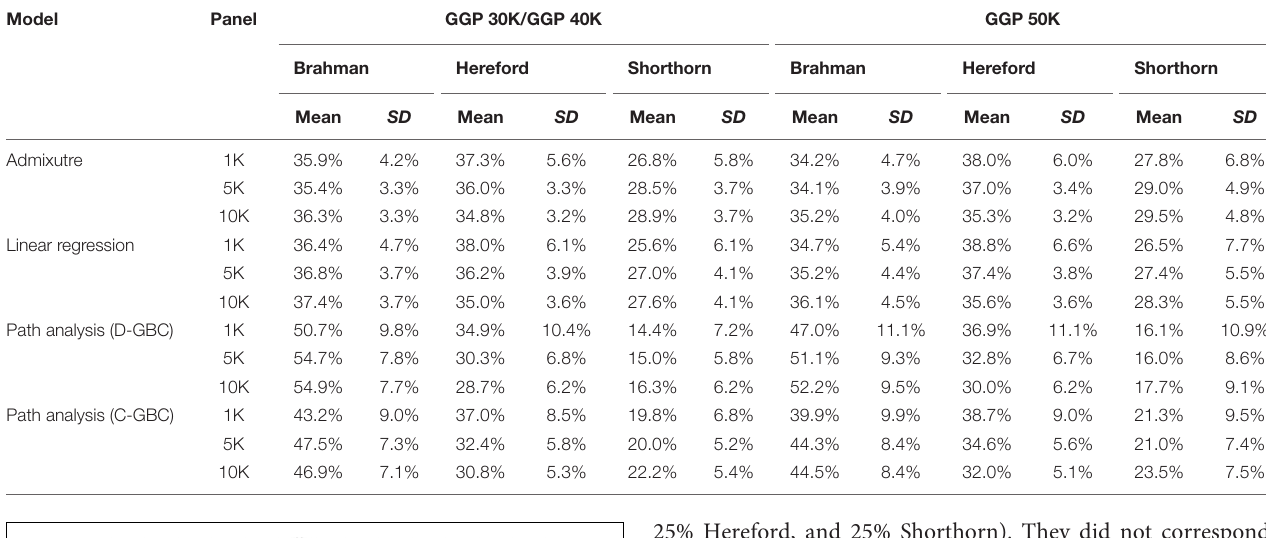
The Beefmaster animals were genotyped on either GGP 30K/GGP 40K bovine SNP chip or GGP 50K bovine SNP chip, respectively. Correlations of allele frequencies were 0.059 (1K), 0.045 (5K) and 0.035 (10K) between Brahman and Hereford, 0.052 (1K), 0.069 (5K) and 0.100 (10K) between Brahman and Shorthorn, and 0.460 (1K), 0.381 (5K) and 0.428 (10K) between Hereford and Shorthorn. TABLE 7 | Comparison of estimated GBC for 7,605 Beefmaster animals with genotype data, obtained by the admixture model, linear regression, and path analysis techniques, respectively. Model